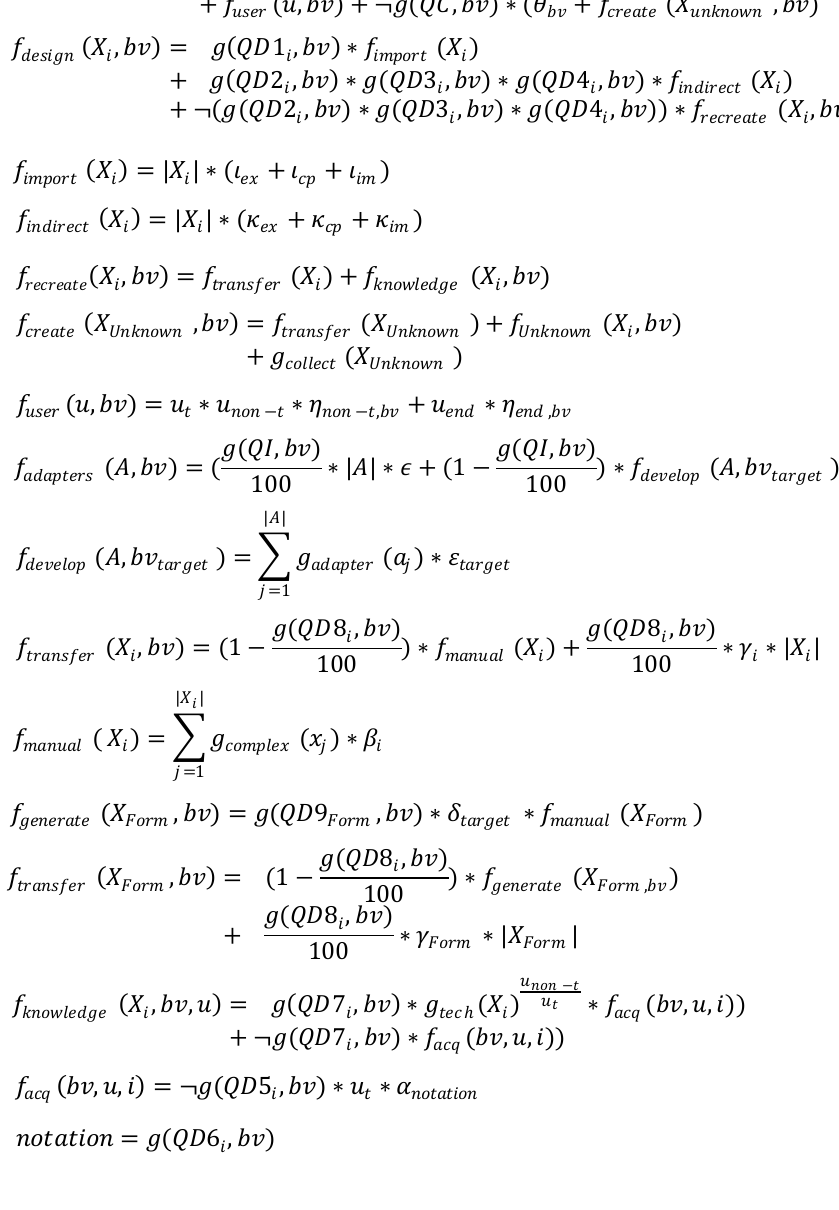
Figure 4. Estimated effort